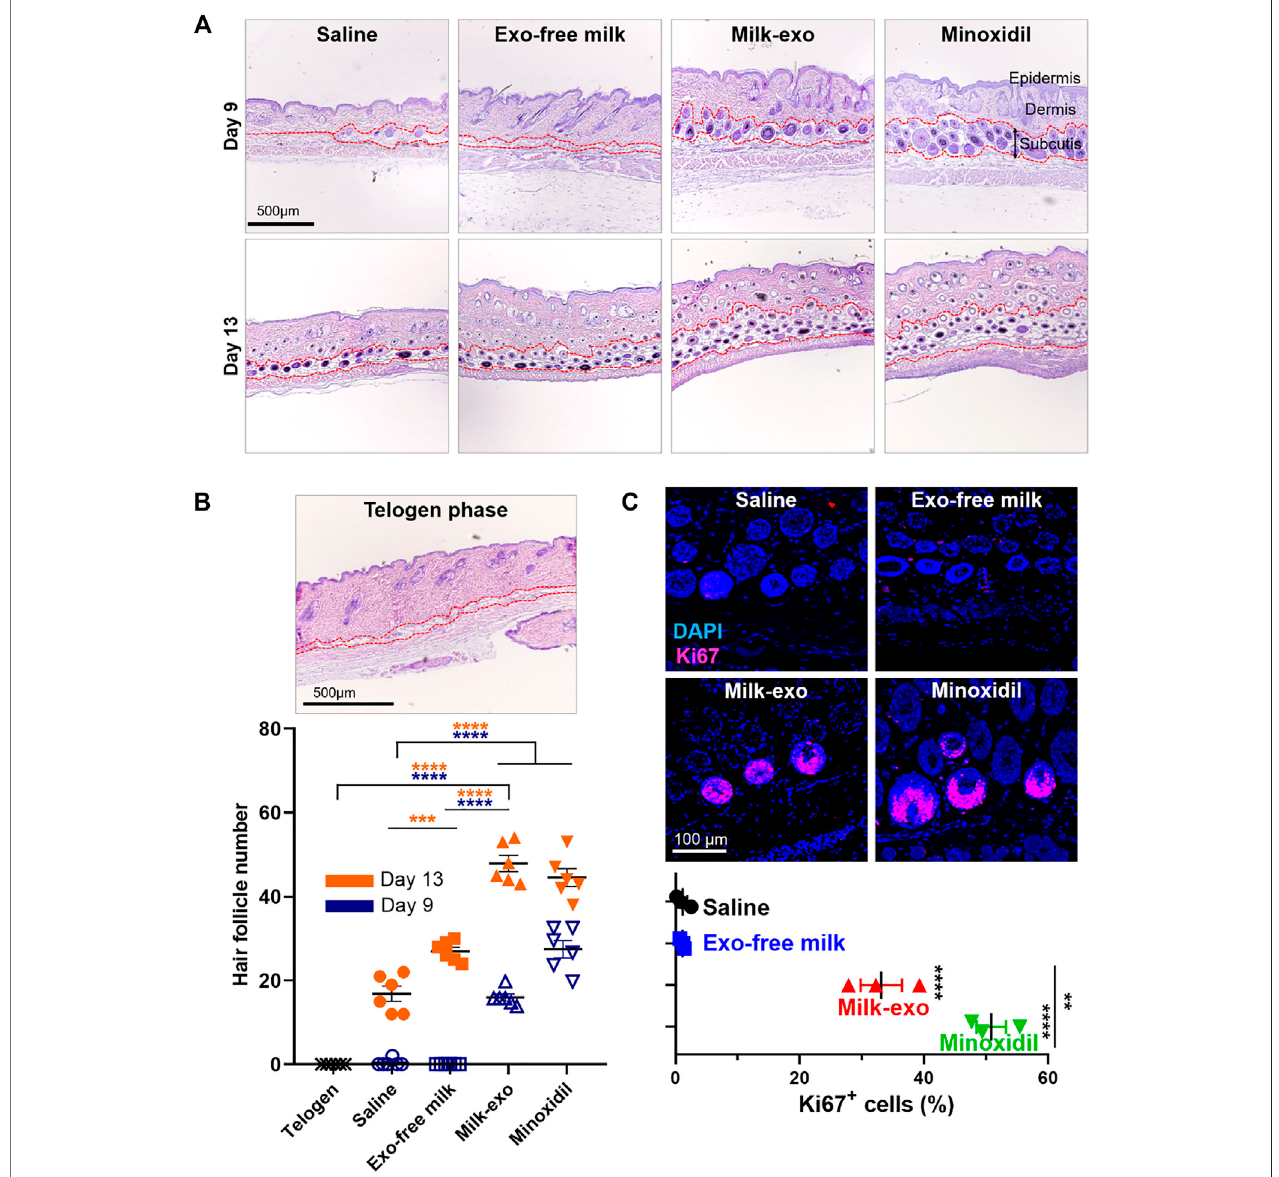
FIGURE 6 | Histological investigation of the acceleration of telogen-to-anagen transition by milk exosomes. (A) Representative hematoxylin-eosin (H&E) images of thedorsalskinsectionforeachgroupondays9and13. (B) Representativeimageoftelogenphaseatday1aftershavingandquanti fi cationofhairfollicleforeachgroups from three tissue samples ( n = 6). (C) Representative images and quanti fi cation graphs showing the expression of Ki67 on day 19 after different treatments from three tissue samples ( n = 3). All data are presented as mean ± SEM (** p < 0.01, *** p < 0.001 and **** p < 0.0001).